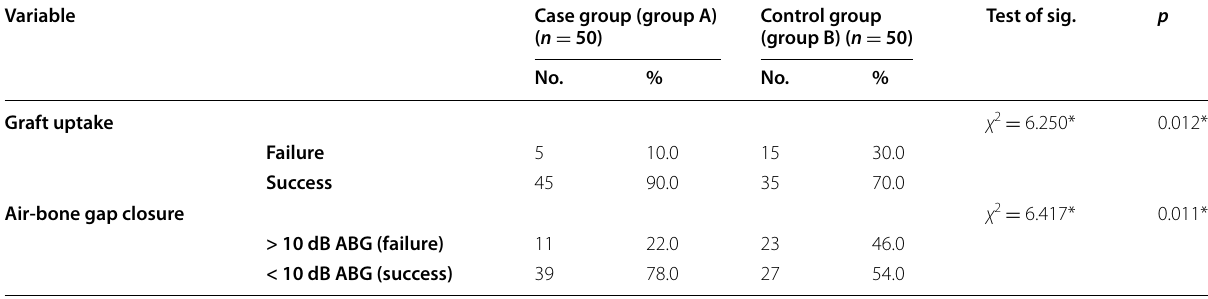
χ 2 chi-square test, p p -value. *Statistically significant at p